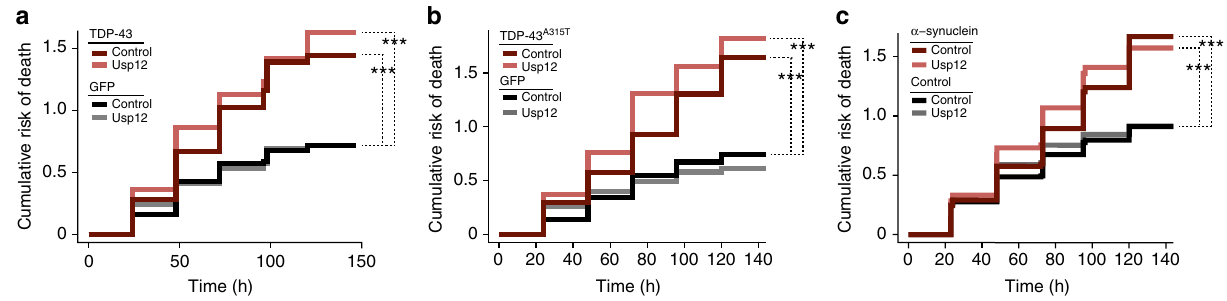
Fig. 2 Usp12 overexpression is not a generic suppressor of neurotoxicity. a – c Cumulative risk of death plots for primary neurons co-transfected with control, TDP-43 ( a ), TDP-43 A315T ( b ), α -synuclein ( c ), and Usp12 or empty vector control plasmids. Cox proportional hazards analysis was used to estimate the relative risk of death, or hazard ratio (HR), and the p value was determined with the log rank test (*** p < 0.001) (Supplementary